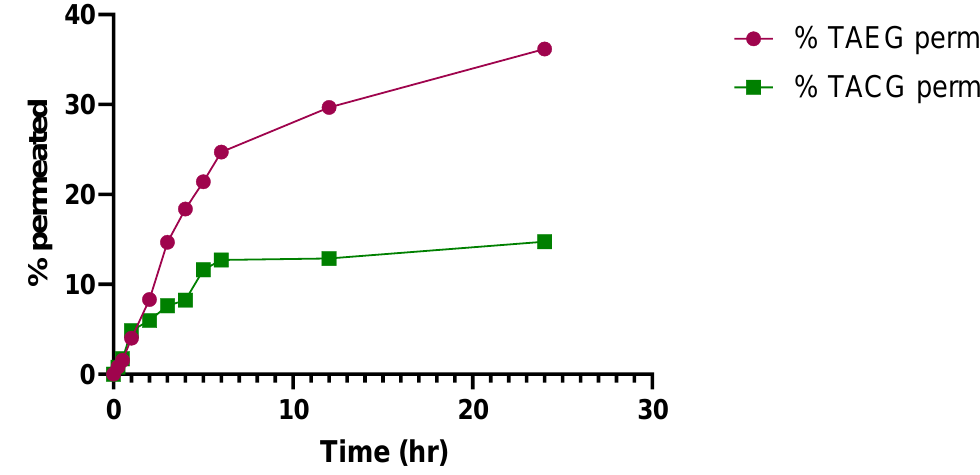
Figure 8. Time-dependent percentage permeation of optimized TAEG (TA-5) and TACG at physiological human skin pH 7.4 and at physiological human temperature (37 °C). Significative differences were observed ( p < 0.05).